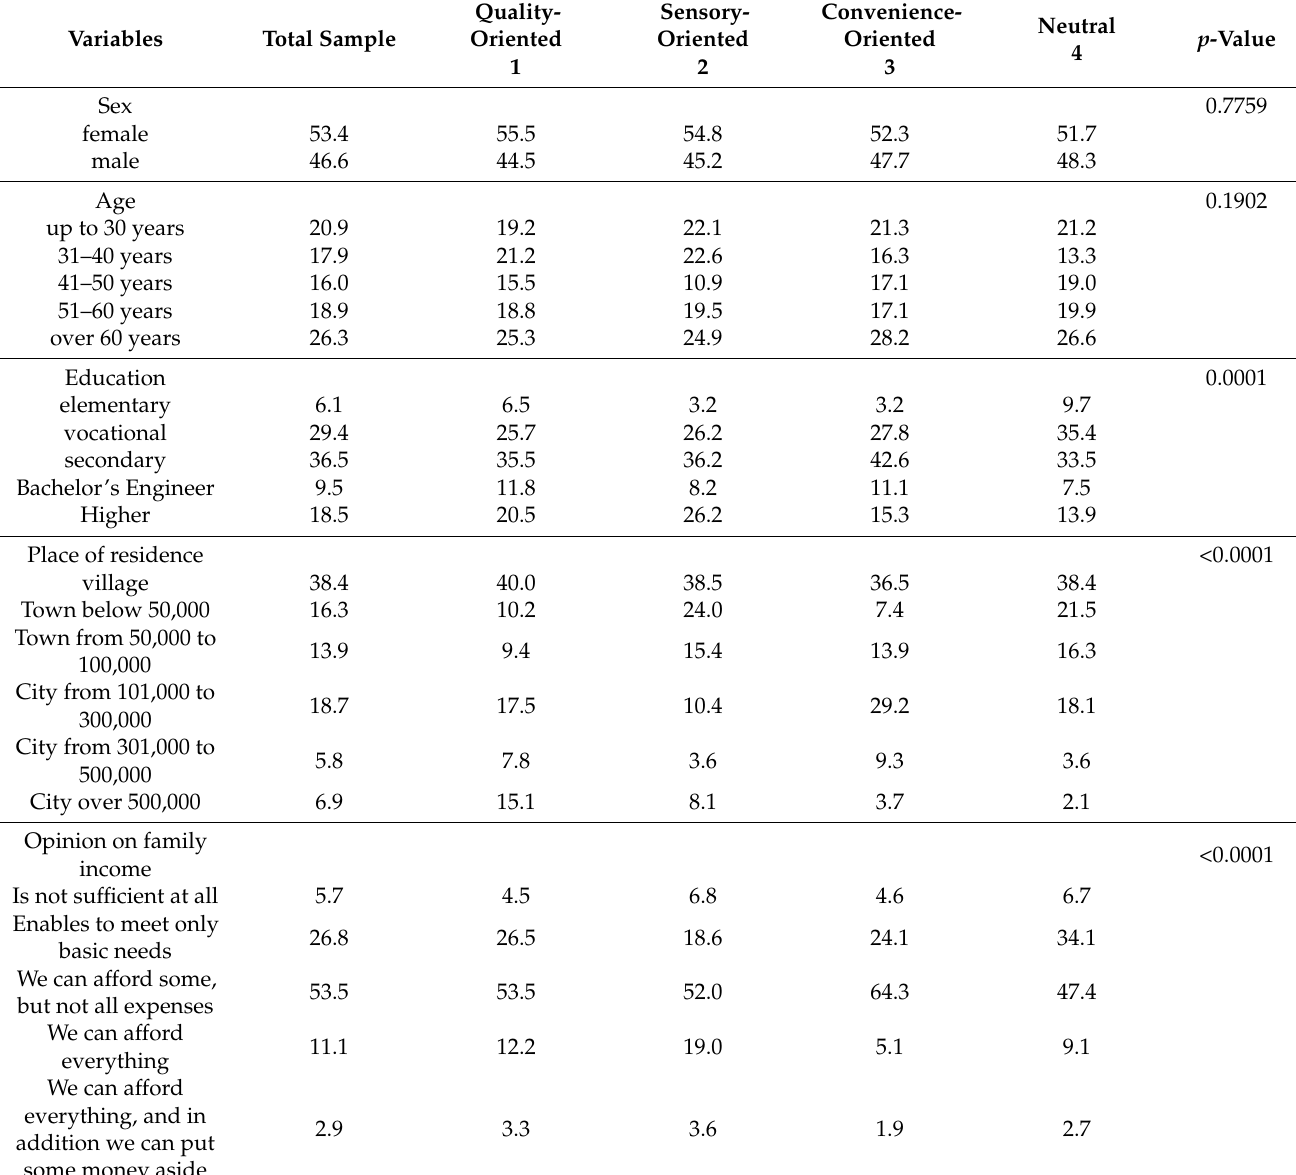
Table 3. Socio-demographic characteristics of the consumers surveyed ( N = 1013,